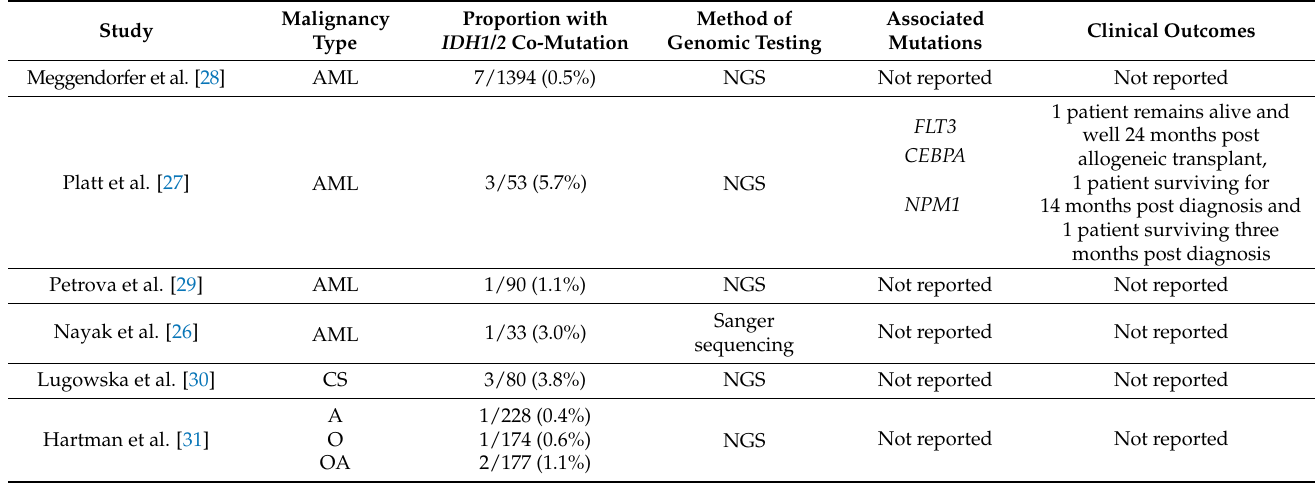
Table 1. Results of literature